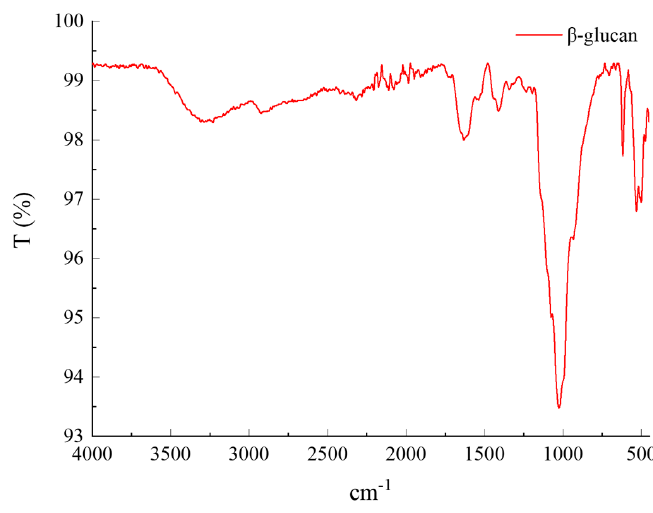
Figure 2. FT-IR of β -glucan.